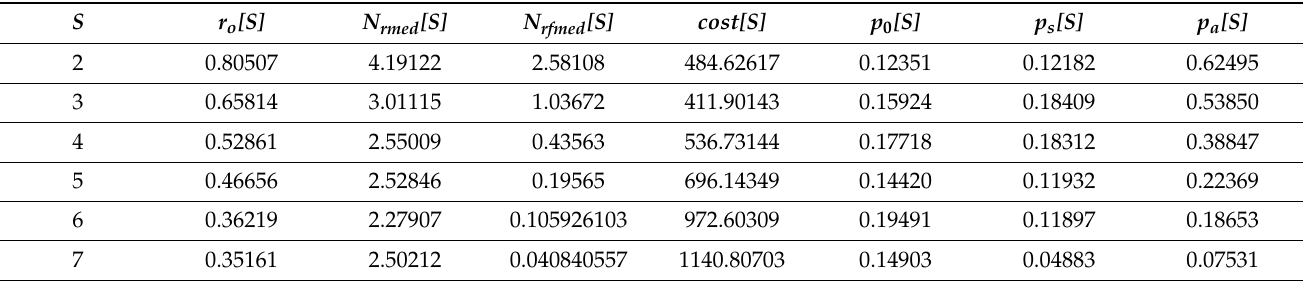
Table A8. Results for hyper-exponential